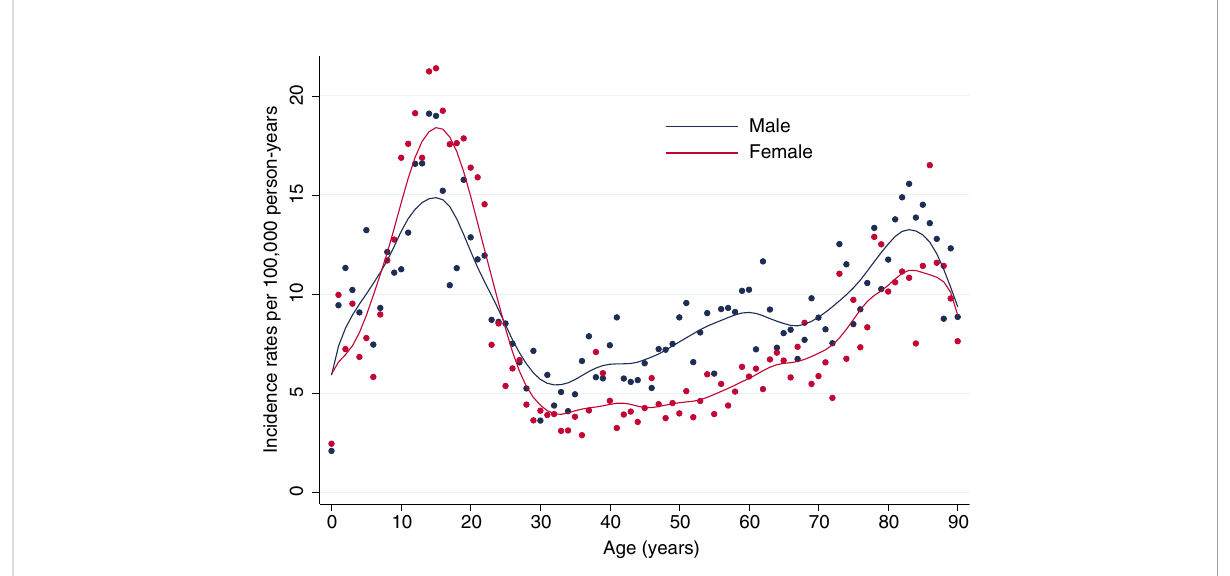
FIGURE 1 Lifetime Incidence Rates of Diabetic Ketoacidosis by Sex. Incidence rates per 100,000 person-years for male (blue) and female (red)